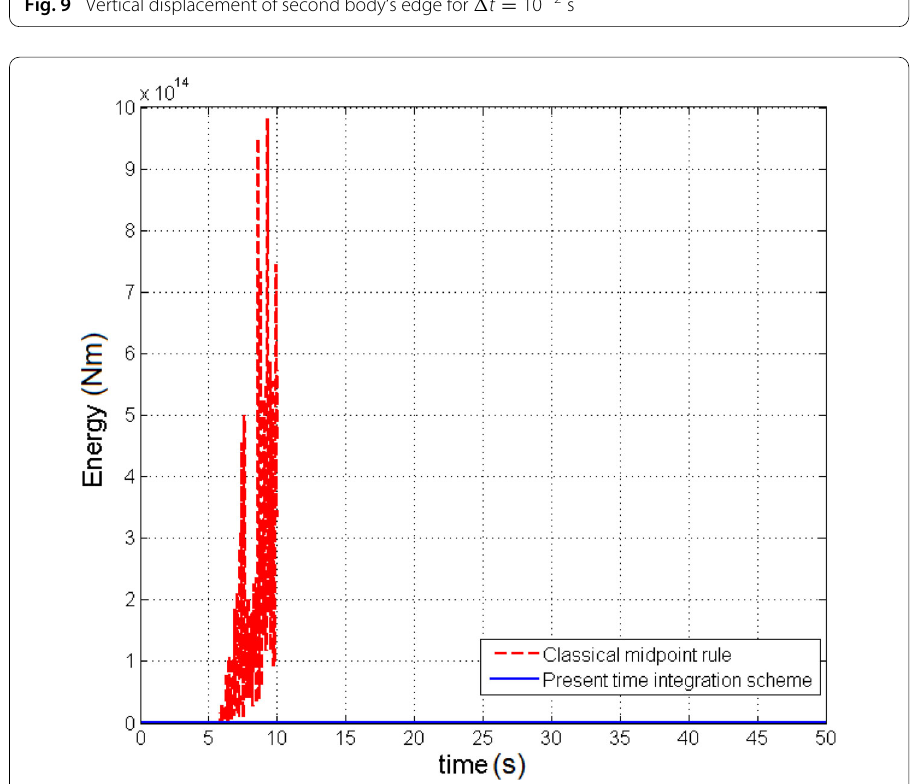
Fig. 10 Energy for (cid:15) t = 10 − 2